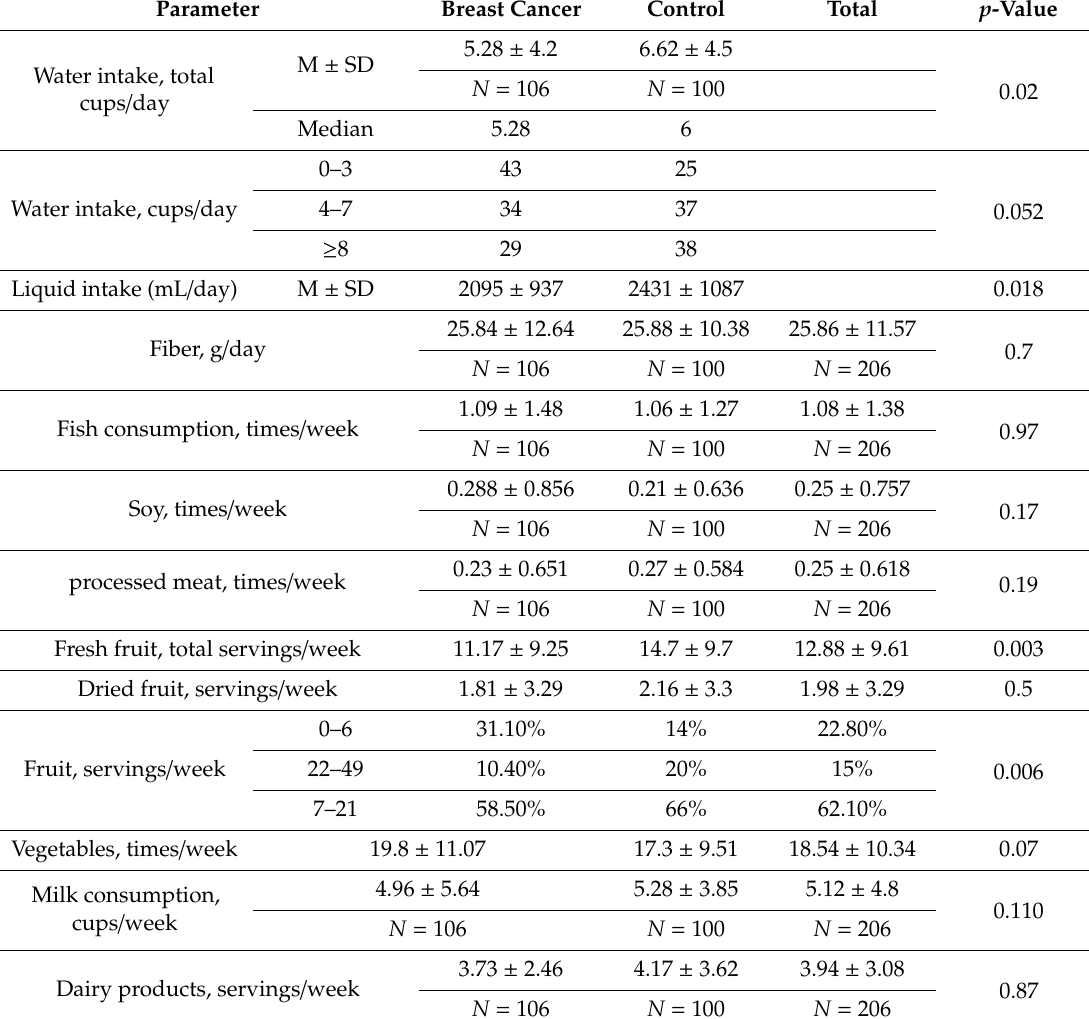
Table 2. Water and total fluid consumption, and other nutritional variables.